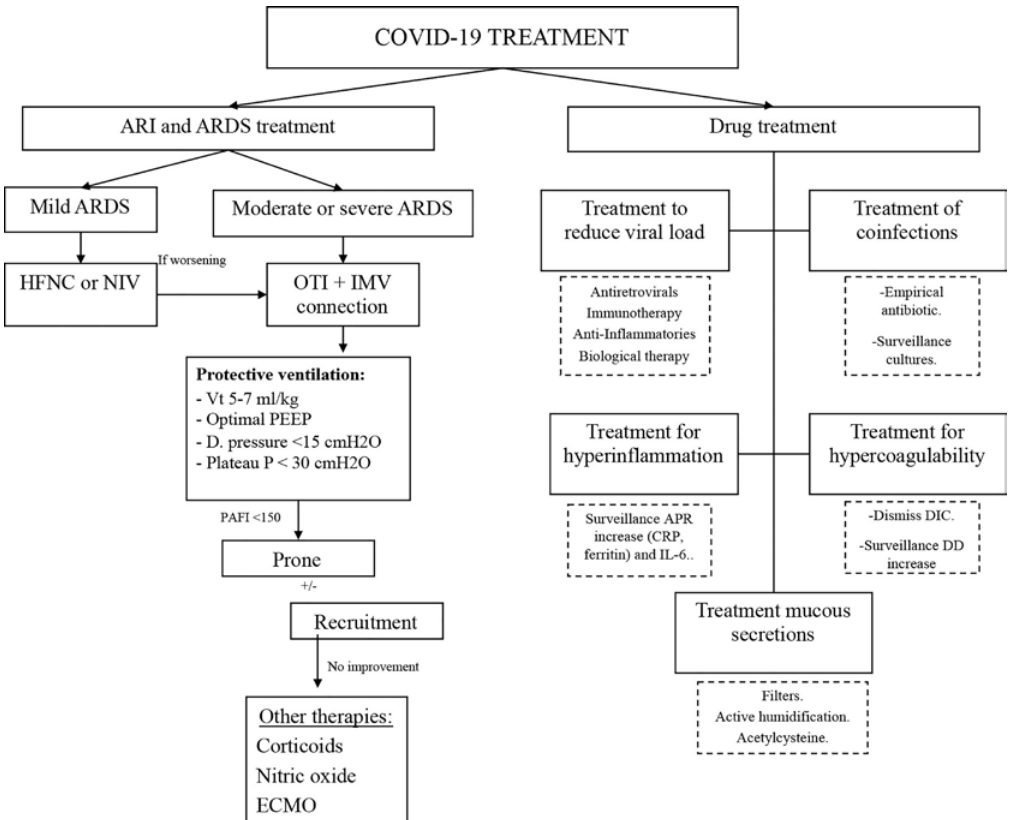
Figure 2 - Treatment of